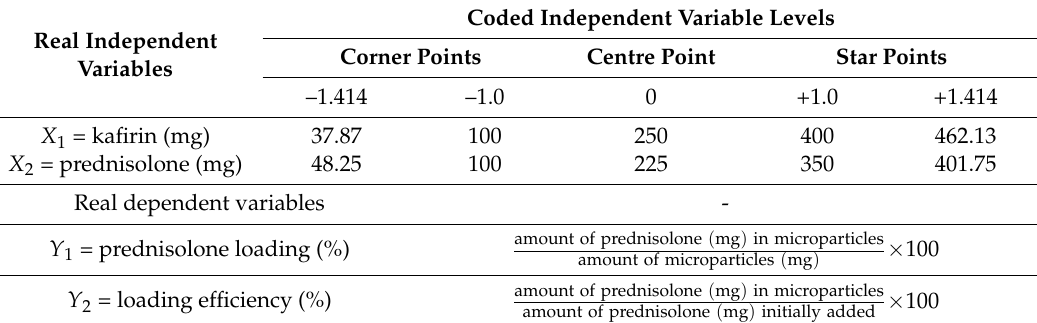
Table 1. Variables in the central composite